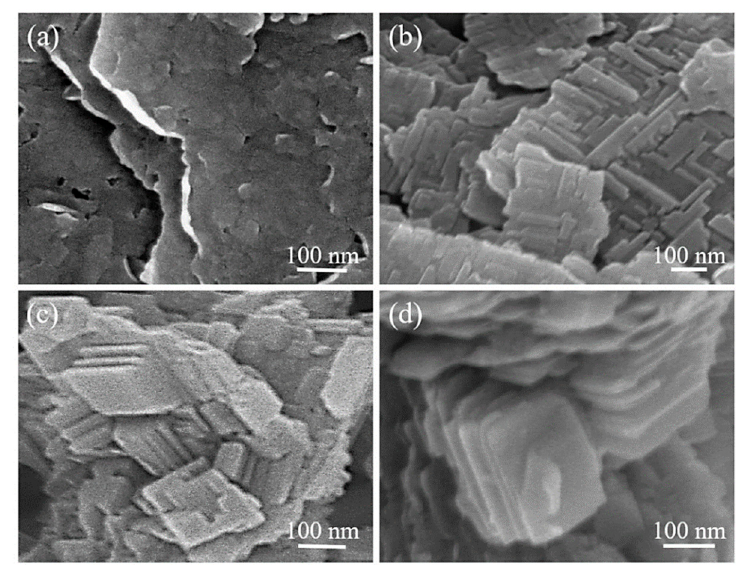
Figure 1. SEM images of 2D Cu-Ni CPs prepared with different amount of TSCD: ( a ) Cu-Ni_0.00; ( b ) Cu-Ni_0.15; ( c ) Cu-Ni_0.20 and ( d ) Cu-Ni_0.25).